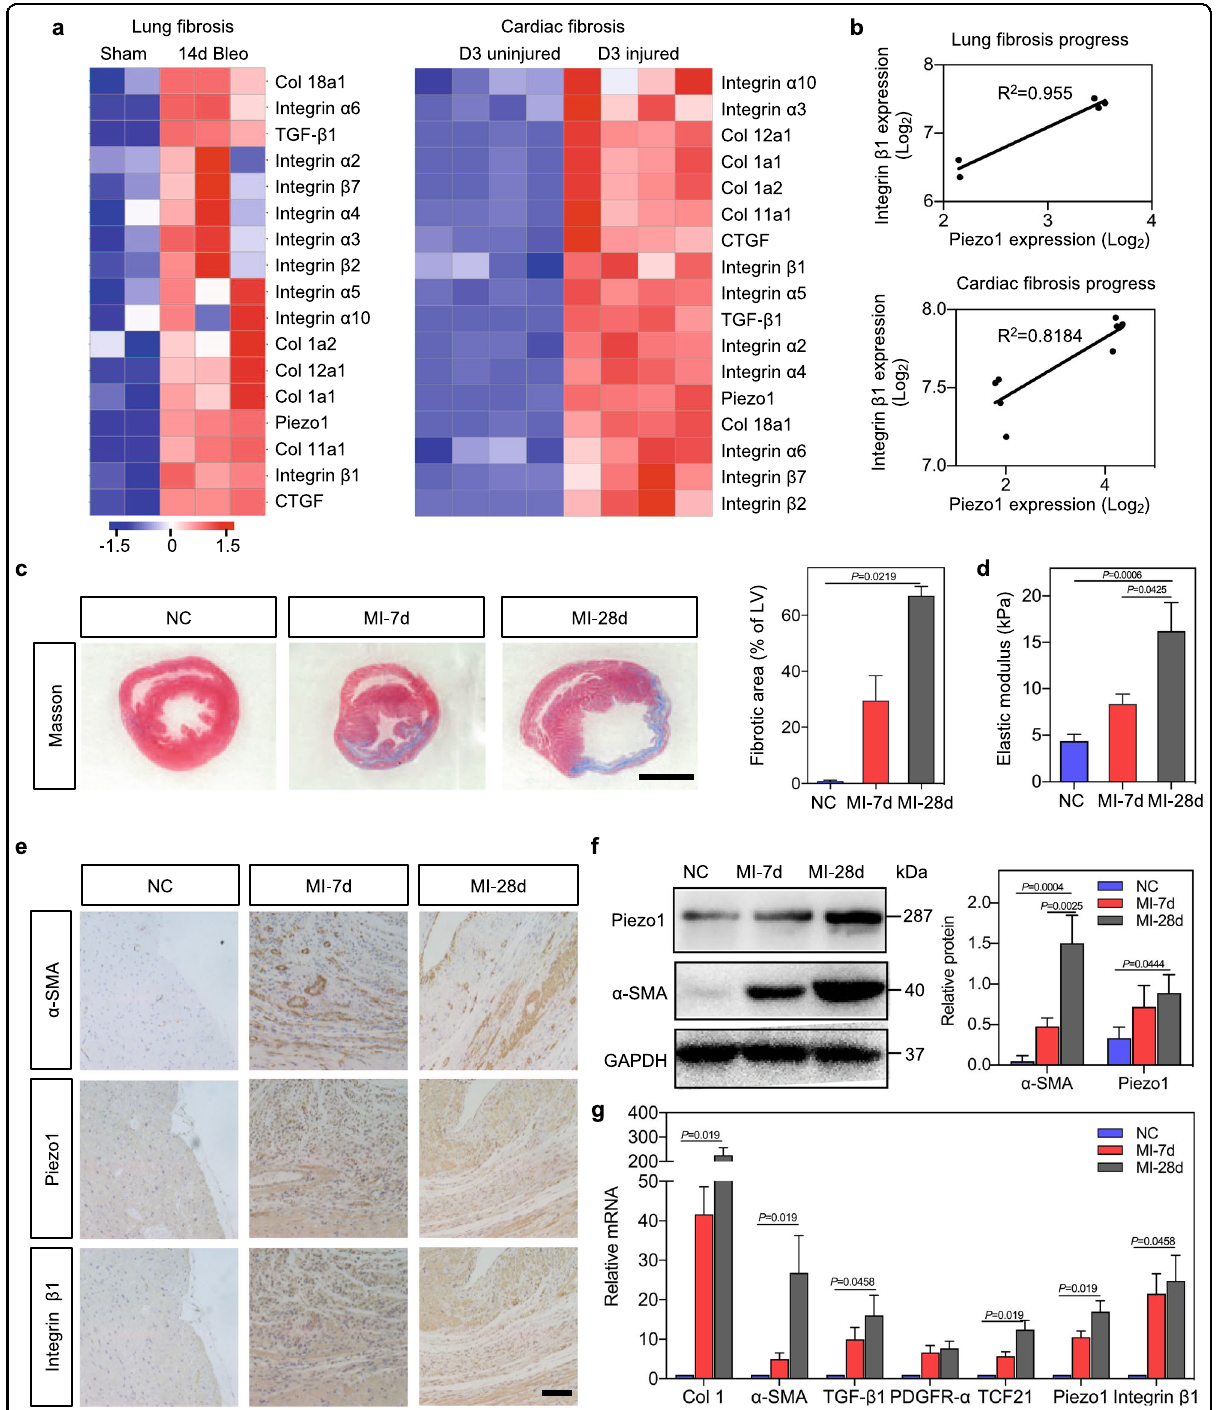
Fig. 1 Enhanced expression of Piezo1 and integrin β 1 arising from tissue stiffening during the onset of cardiac fi brosis. a Meta-analysis of published GEO data analysis showing Piezo1, integrin, collagen and connective tissue growth factor (CTGF) expression in lung fi brosis (bleomycin- mediated lung fi brosis, “ Bleo ” ) and heart with sham and injury. b Correlation of Piezo1 and integrin β 1 expression in the lung and heart with sham and fi brosis in GEO data. c Representative images of Masson ’ s trichrome-stained sections from the negative control (NC) and MI rats. Scale bar, 5 mm (LV: left ventricular). d Elastic modulus of the heart sections from NC and MI rats. The elastic modulus of the heart tissue increases from 4.35 kPa (NC) to 8.38 kPa (MI-7d) fi nally to 16.22 kPa (MI-28d). e Immunohistochemical staining of α -SMA, integrin β 1, and Piezo1 in the cardiac tissues of NC and MI rats. Scale bar, 200 μ m. f Relative protein levels of α -SMA and Piezo1 determined by Western blot analysis. g RT-PCR analysis of Col 1, α -SMA, TGF- β 1, PDGFR- α , TCF21, Piezo1, and integrin β 1 in NC and MI